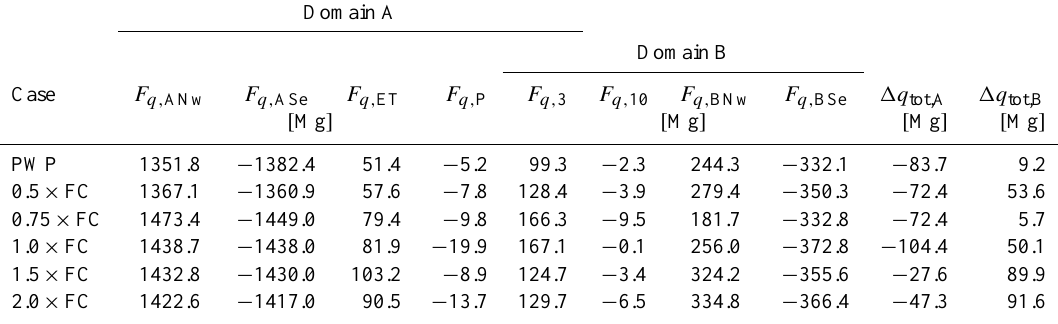
Table 3. Total integrated moisture flux ( F q ) into Nam Co Lake basin between 06:00 and 16:00BST. The control domains denoted with subscripts A and B are indicated in Fig. 11g. The subscripts Nw, Se stand for the north-west and south-east boundaries. Positive fluxes across the lateral boundaries indicate flux into the domain. ET and P are the evapotranspiration and precipitation flux; 3 and 10 indicate the vertical boundaries of the control volumes, with a negative sign for upward flux. (cid:49)q tot is the total net moisture flux for a